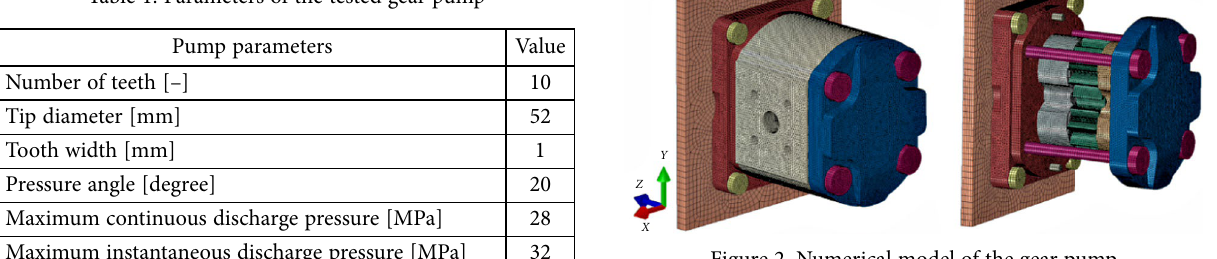
Figure 2. Numerical model of the gear Table 2. Properties of the materials used in the pump